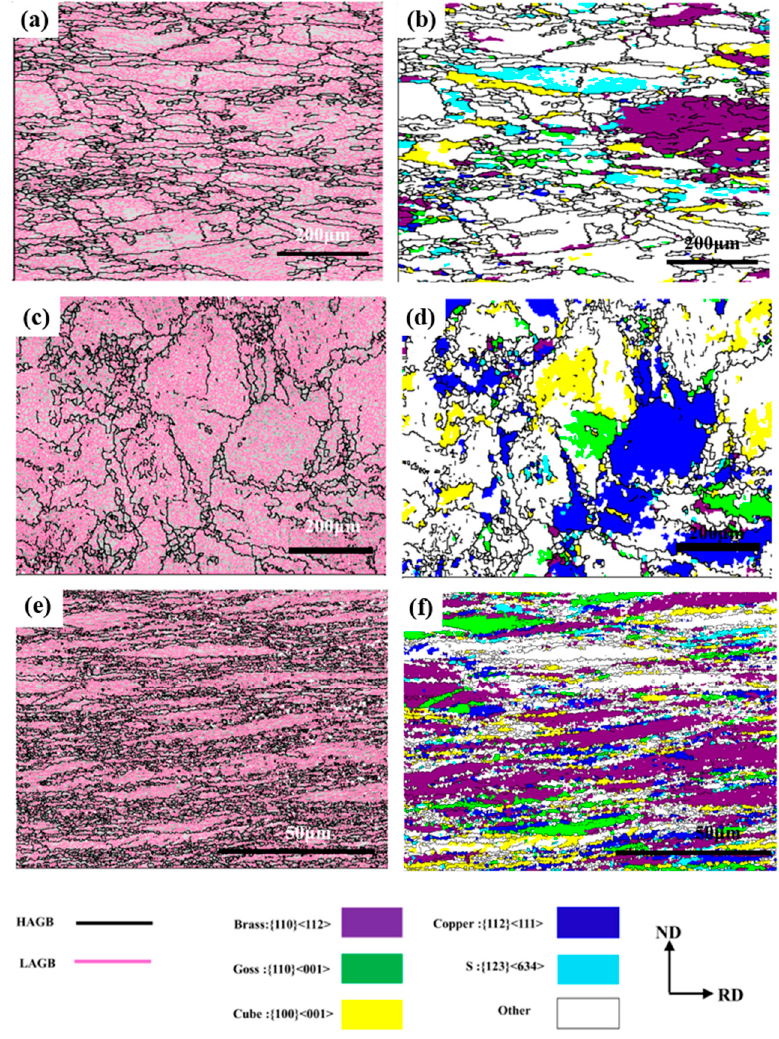
Figure 8. Grain boundary diagram ( a , c , e ), and crystal orientation map ( b , d , f ) of Cu-0.1Al alloy under cross rolling: ( a , b ) UR-54%; ( c , d ) UR-70%; ( e , f ) UR-90%.